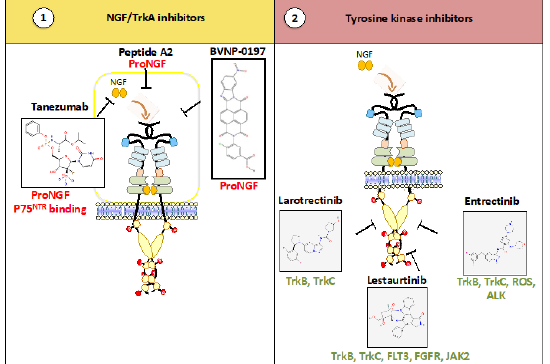
Figure 1. NGF/TrkA inhibitors. Two main types of molecules have been designed to impede NGF/TrkA signaling ( 1 , 2 ). First are molecules that block the NGF/TrkA association ( 1 ). Tanezumab is a monoclonal antibody that binds NGF. Peptide A2 and BVNP-0197 also bind NGF but do not promote P75 NTR signaling. Second are compounds that inhibit TrkA phosphorylation ( 2 ). The three inhibitors are ATP competitors but have different specificities and inhibit other receptors